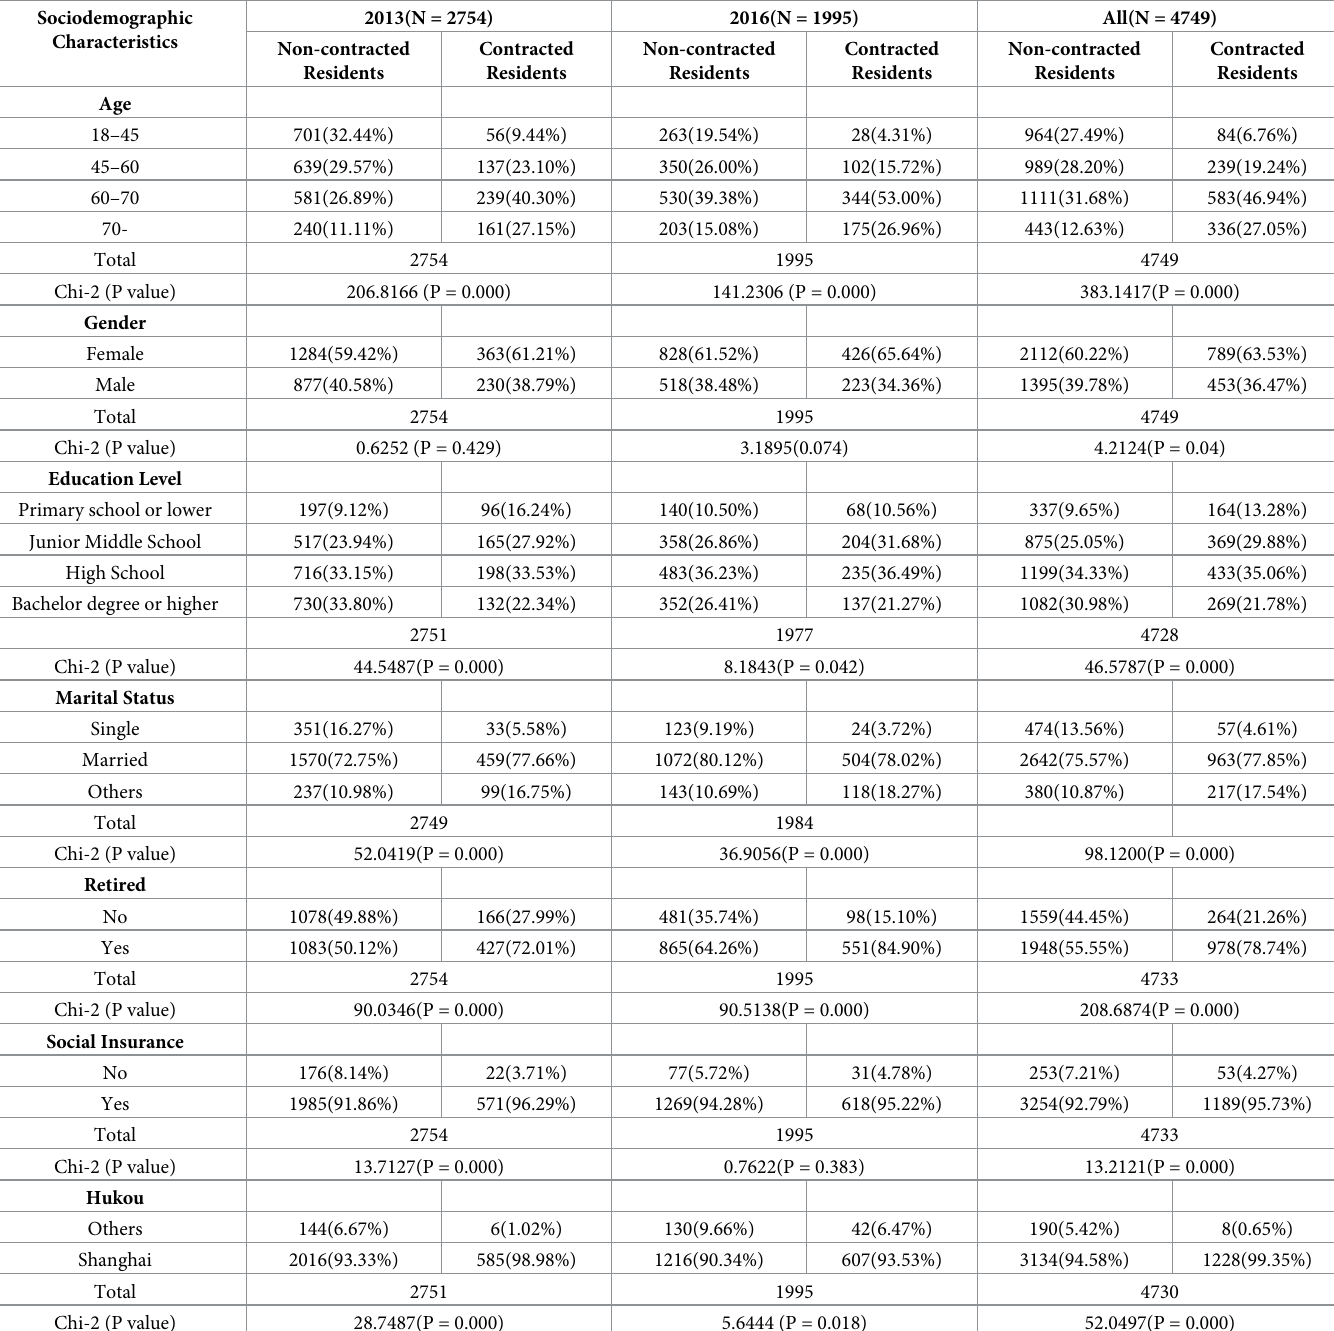
Table 2. Distribution of contract rate stratified by sociodemographic characteristics,